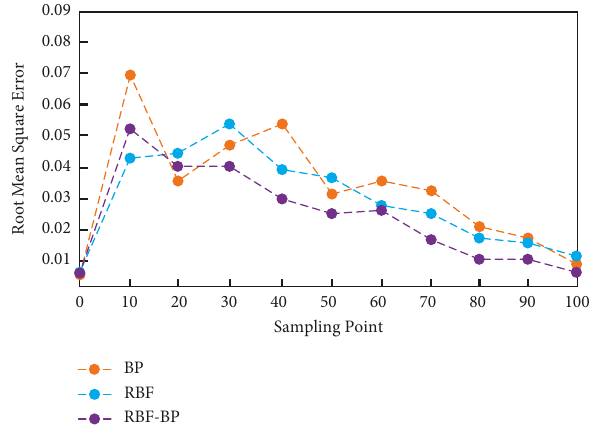
Figure 7: Comparison of prediction results of different neural network algorithms.